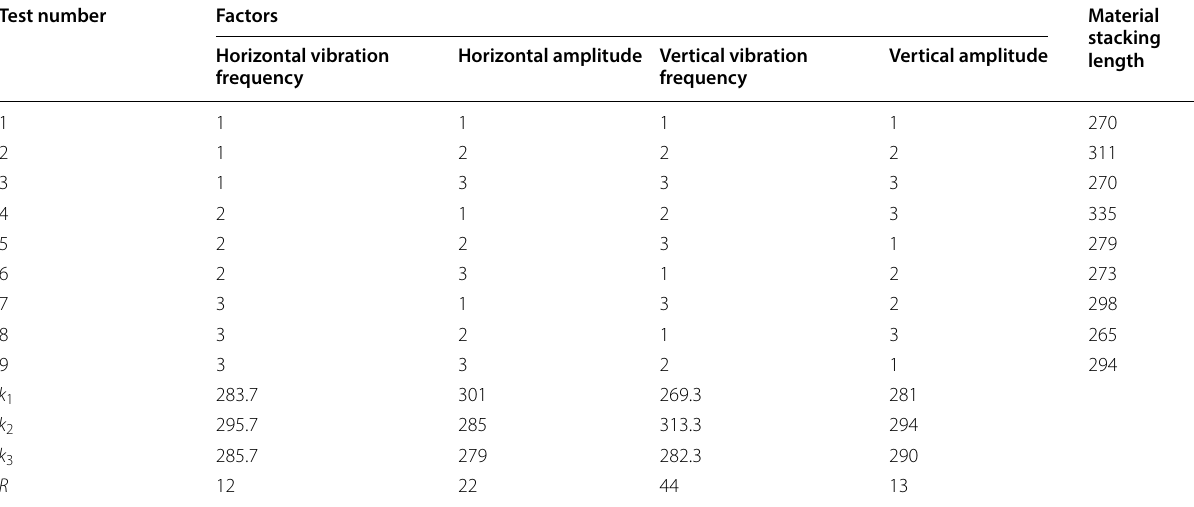
Table 2 Orthogonal test results of automatic material tidying process Test